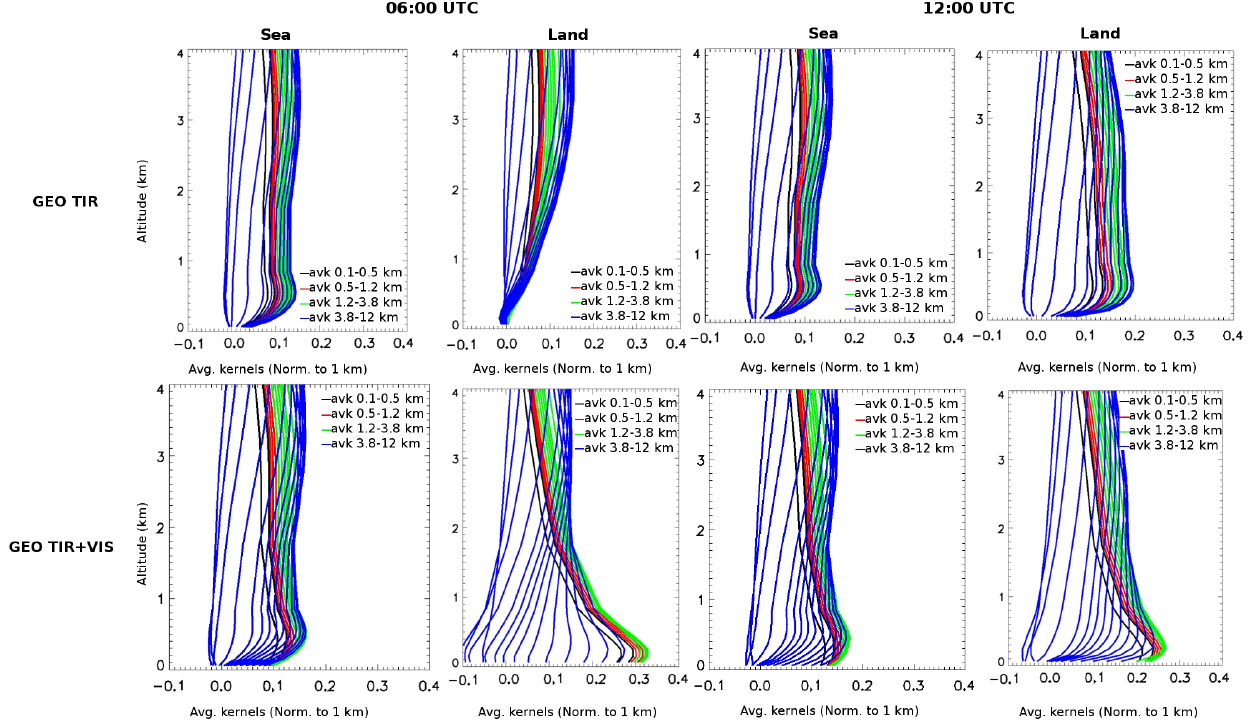
Figure 4. As in Fig. 3 except for over-sea pixels (first and third columns) and land pixels (second and fourth columns) at 06:00UTC and